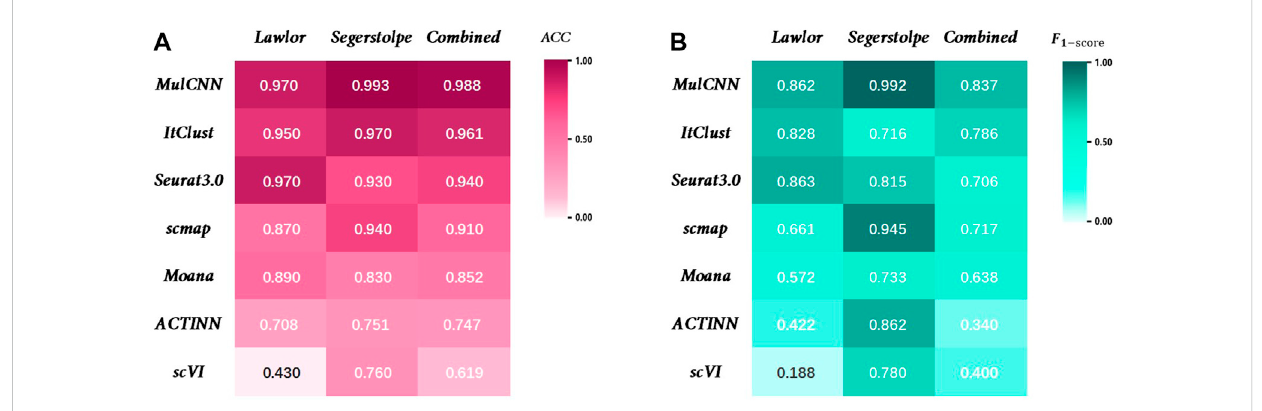
FIGURE 5 PerformancecomparisonofMulCNNandothersupervisedalgorithms. (A) AccuracycomparisononthedatasetsLawlor,Segerstolpe,Combined. (B) F 1-score comparison on the datasets Lawlor, Segerstolpe,Combined.